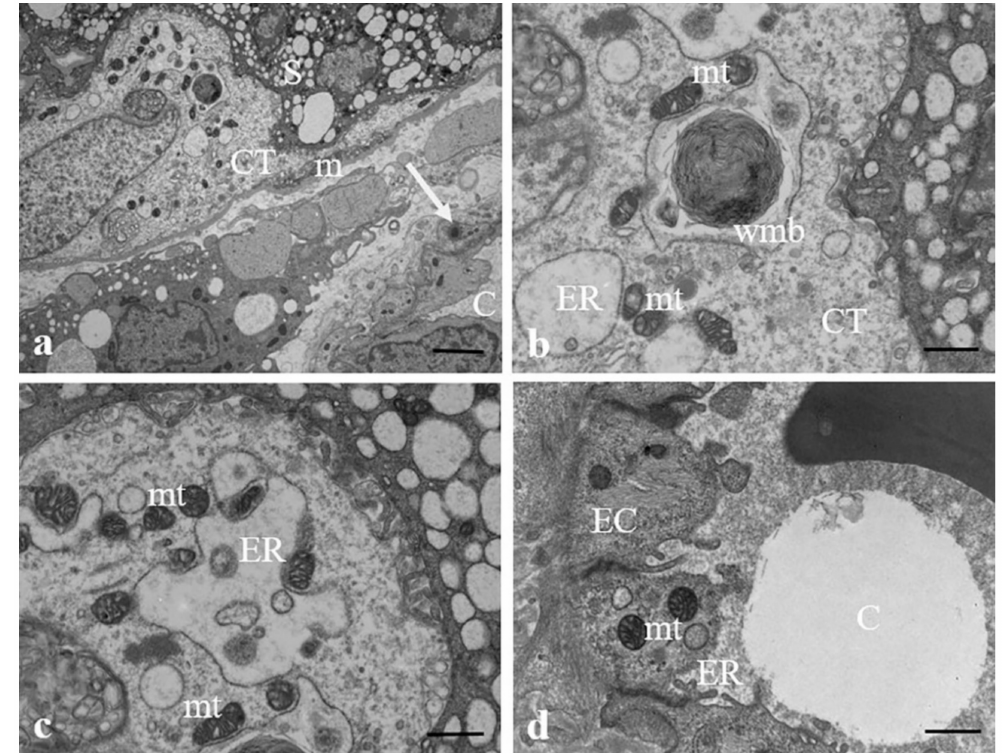
Figure 6. Ultrastructural changes of organelles in the cytotrophoblast cells. ( a – c ) Micrographs of the cytotrophoblast layer (CT) in which it is possible to observe in the cytoplasm of the cell dilated vesicles of ER, numerous electrodense swollen mitochondria (mt) and whorled membranous bodies (wmb) derived from involuting ER and other structures. ( d ) Changes in the structure of ER and mitochondria occur also in endothelial cells (ECs) surrounding the fetal capillaries (C). MP (arrow) in a pericyte is seen ( a ). Bar, 2 µ m ( a ) and 800 nm ( b – d